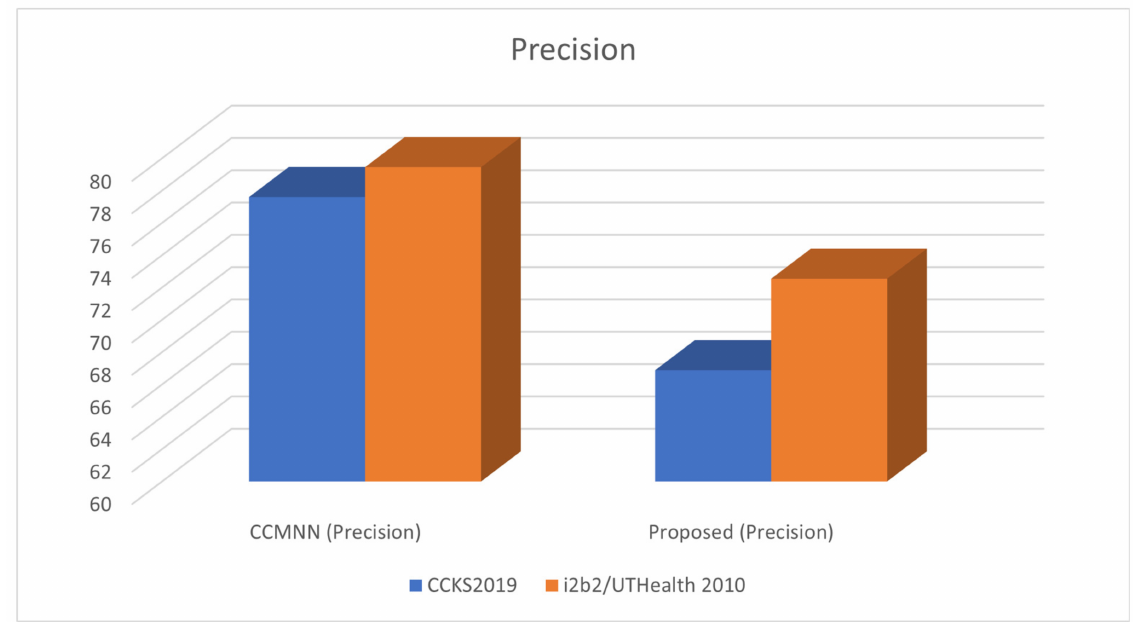
Figure 4. Assessing Precision in Clinical Record Analysis using the I2B2/UTHEALTH 2010